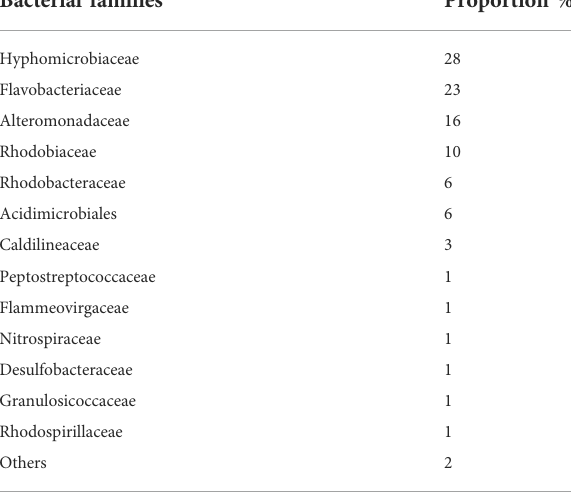
TABLE 2 Relative abundance of the bacterial families from the anoxic intertidalzoneoftheRiverDeeestuary.DataobtainedfromMiSeq DNA gene sequences. A detailed description and characterization of the microbial community and how it was sampled is given in Curtis-Harper et al.